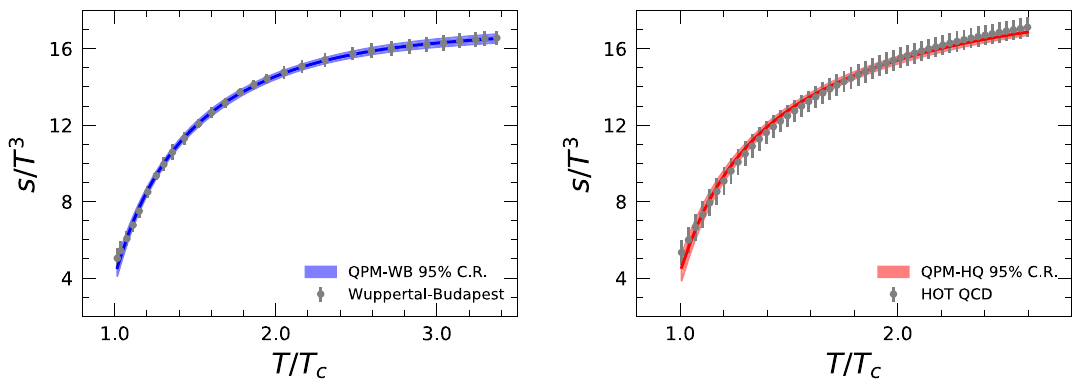
Fig. 1 The entropy density s ( T ) from the quasi-particle model (QPM) is fitted to the lattice QCD data from Wuppertal–Budapest [115] and the Hot QCD [116] Collaborations. The bands show the 95% confidence intervals